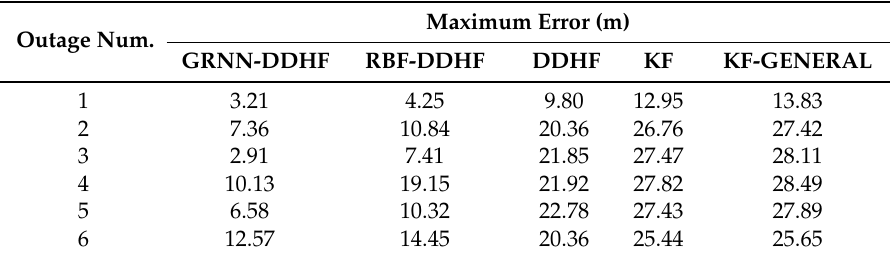
Table 2. Maximum position errors during GPS outages for Trajectory 1.